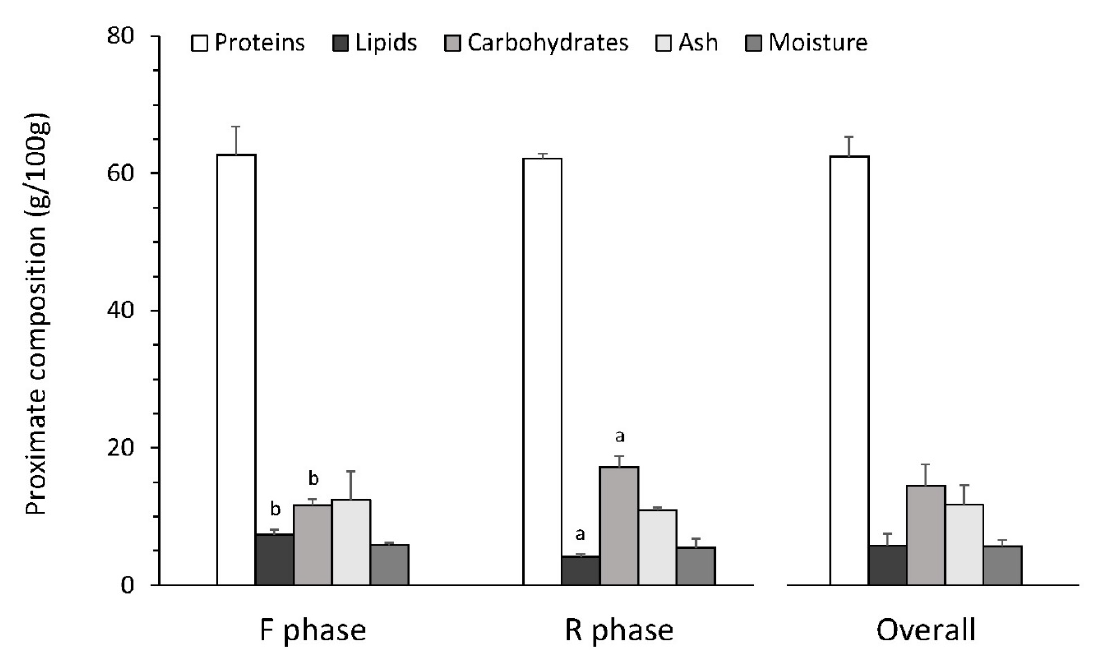
Figure 2. Biomass average proximate composition (as % of proteins, carbohydrates, lipids, ash and moisture) for samples of A. platensis BEA 1257B collected during the first experimental phase (F phase, 12 Sep. to 11 Oct., samples F1, F2 and F3) and during the second phase of the experiment (R phase, 11 Oct. to 11 Nov., samples R1, R2 and R3) from the 8000 L raceway pond inside greenhouse during the long-term semi-continuous cultivation. The overall composition of the biomass is also reported. For each parameter, letters above bars indicate: a = significant difference with the F phase, b = significant difference with the R phase. Data are presented as the mean of three samples for F and R phases, and as the mean of six samples overall, with error bars representing the corresponding standard deviation ( ± SD). Legend: White graph bars—Proteins; Black graph bars—Lipids; Gray graph bars—Carbohydrates; Light gray graph bars—Ash; Dark gray graph bars—Moisture.